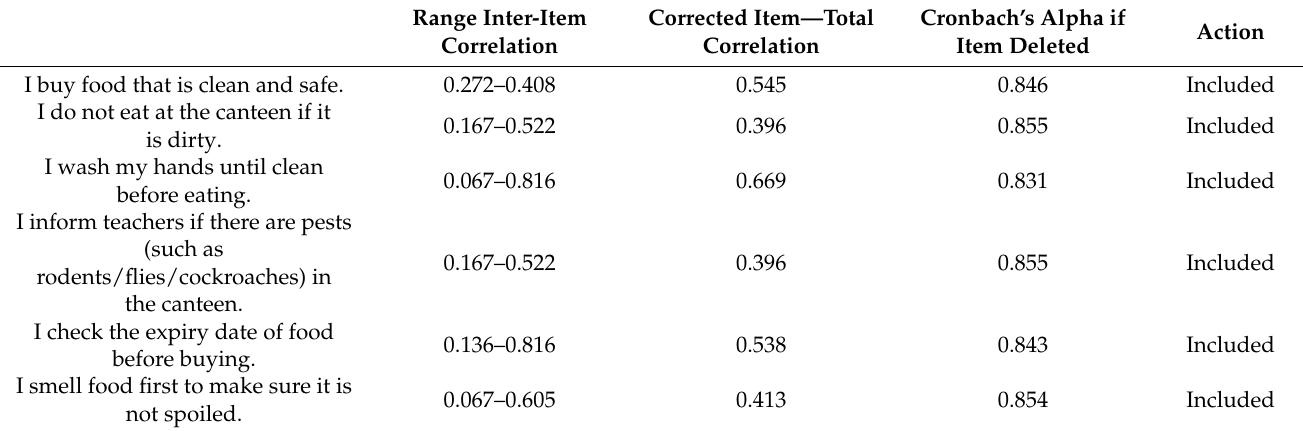
Table 4. Item analysis of practice toward prevention of food